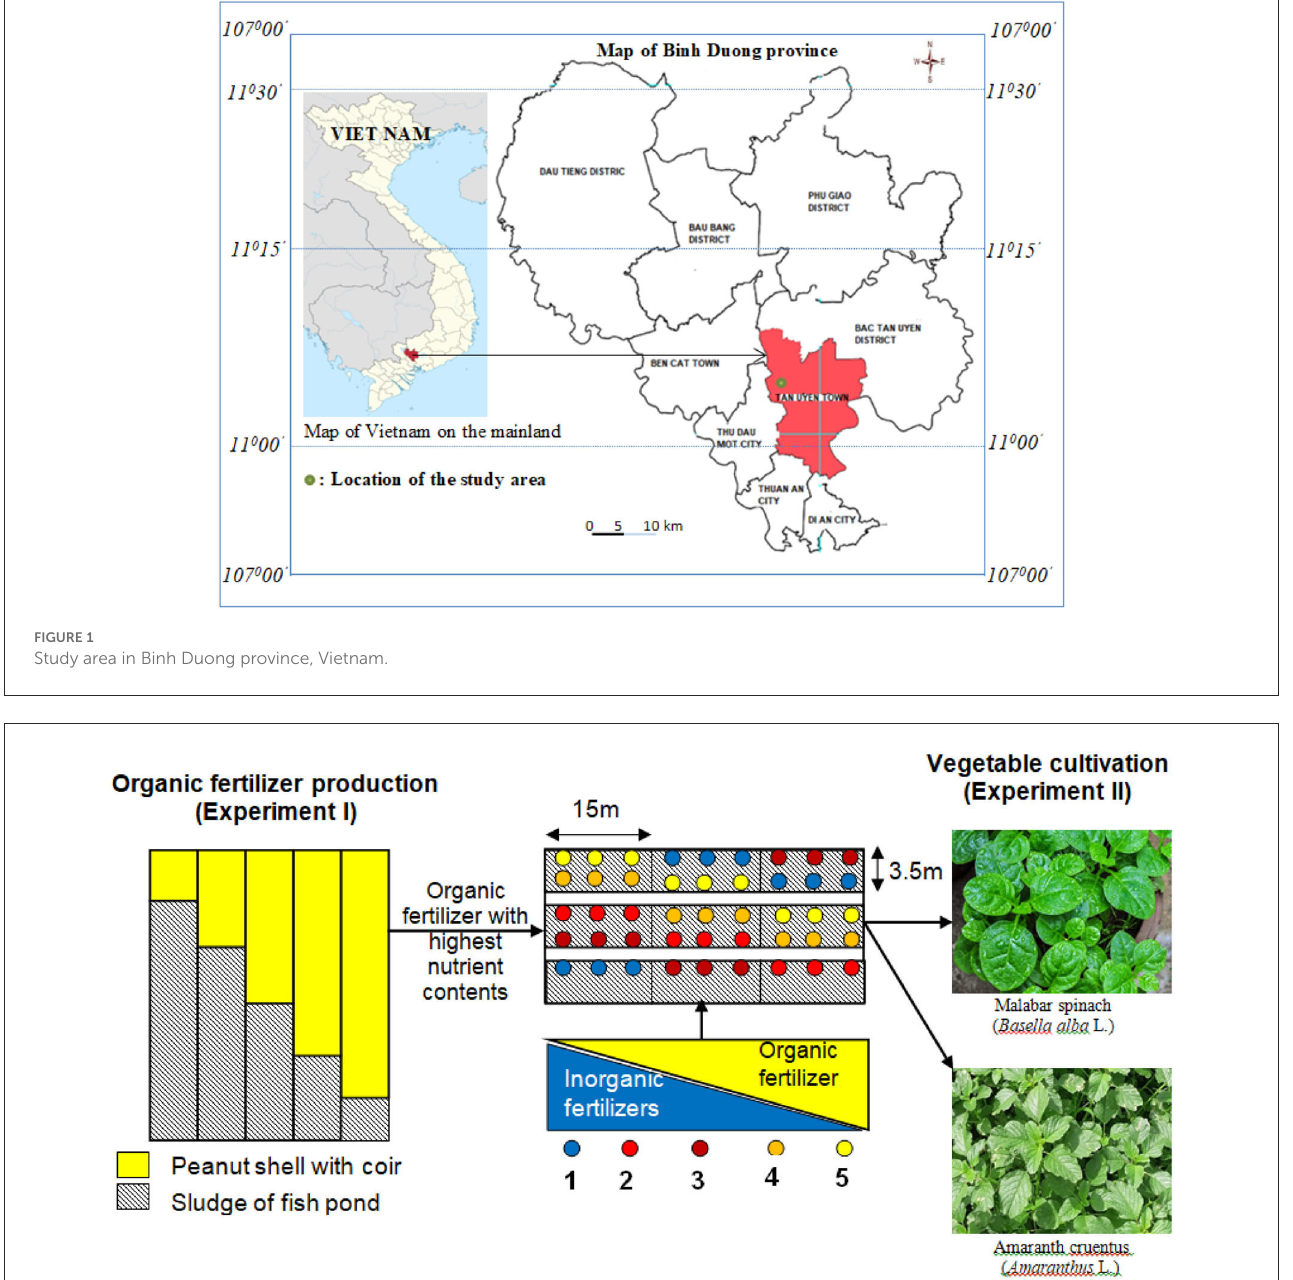
FIGURE2 Layout of the Malabar spinach ( Basella alba L.) and Amaranthus cruentus ( Amaranthus L.) vegetables cultivation fertilized by the different organic fertilizer and chemical fertilizer